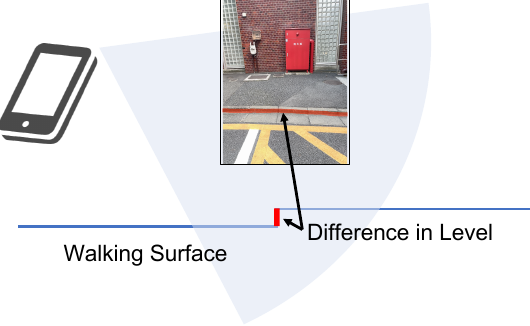
Figure 1. Illustration of an example of a difference in